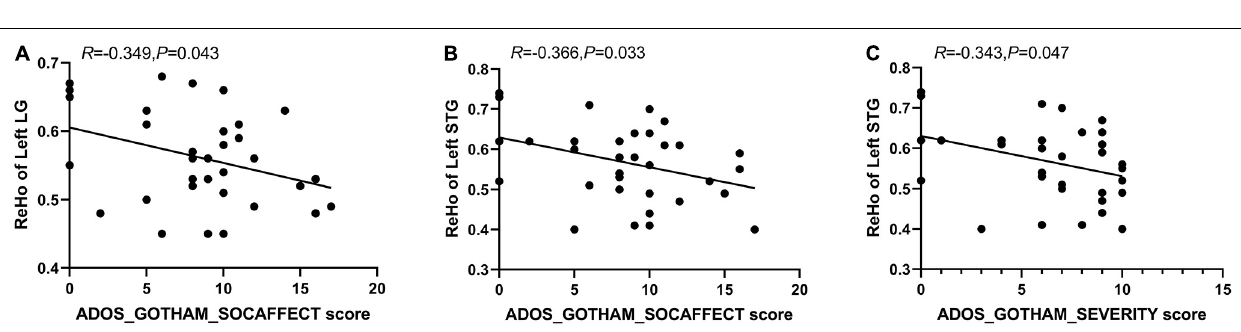
FIGURE 2 | ALFF/ReHo signal values for altered regional brain regions between boys with ASD and TDs. ∗∗ means p < 0.01, ∗∗∗ means p < 0.001.